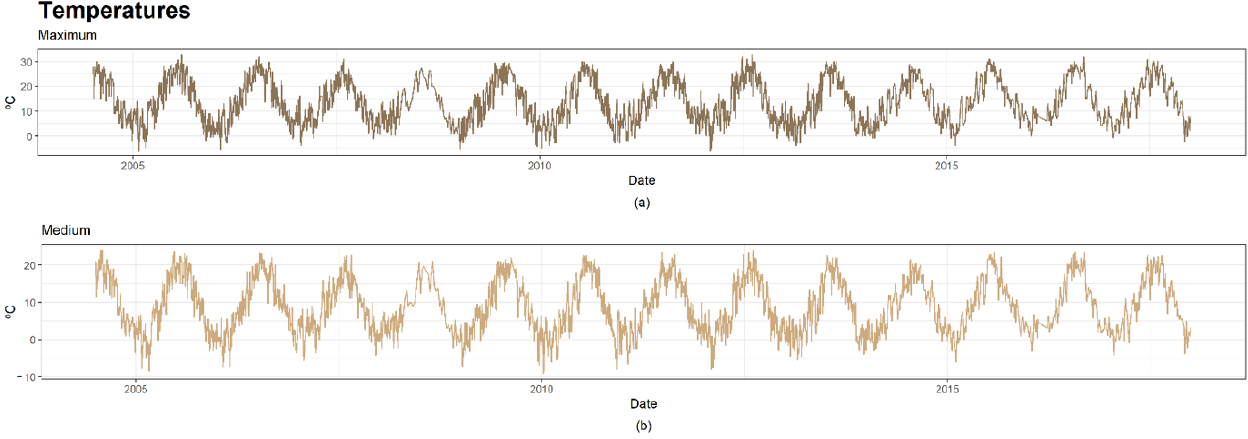
Figure 6. Cross-section ( a ), Plan ( b ) and section ( c ) of the dam. The source of this figure relies on